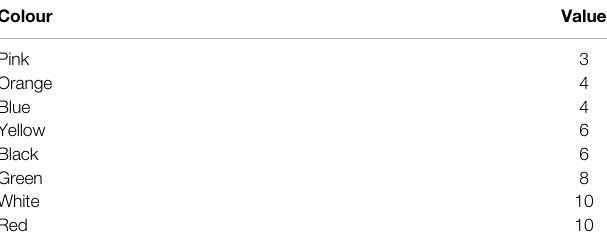
TABLE 1 | The list of colours, and their values, that participants could consult during the experiments.